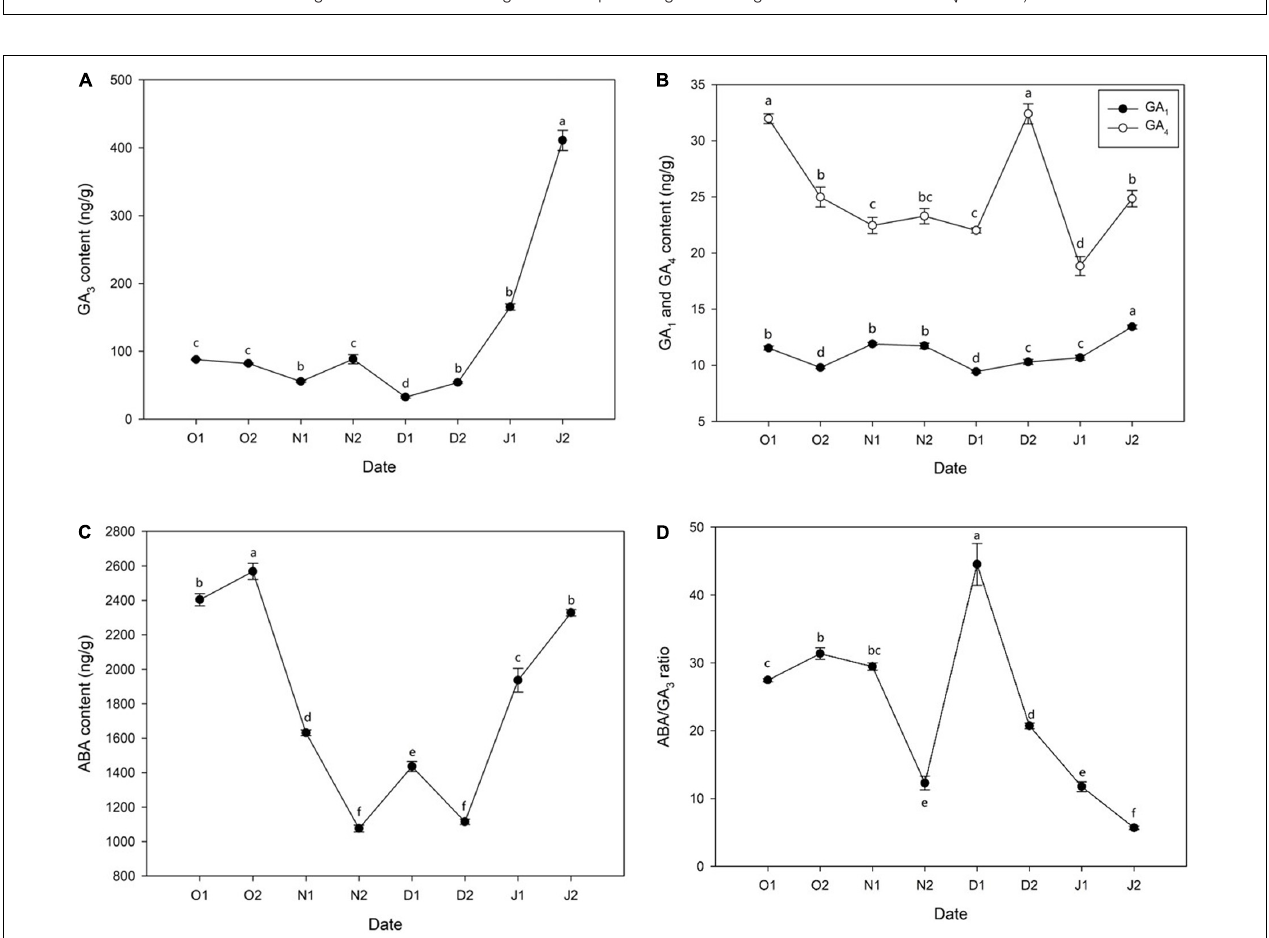
FIGURE 2 | Concentration of phytohormones [ (A) gibberellin 3 (GA3), (B) gibberellin 1 (GA1) and gibberellin 4 (GA4), (C) abscisic acid (ABA), (D) ABA/GA3 ratio] in Magnolia wufengensis during the season transition in 2020–2021. Each experiment was performed with three biological replicates. Different letters above bars indicate a significant difference among hormones according to ANOVA and LSD test ( p <